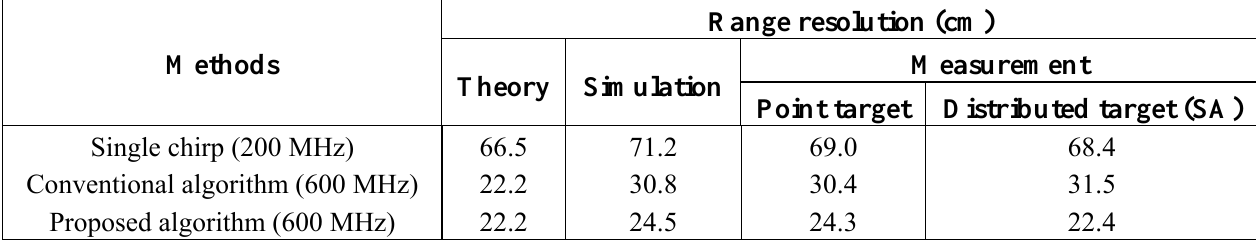
Table 2. The summary of the range resolution measured by several